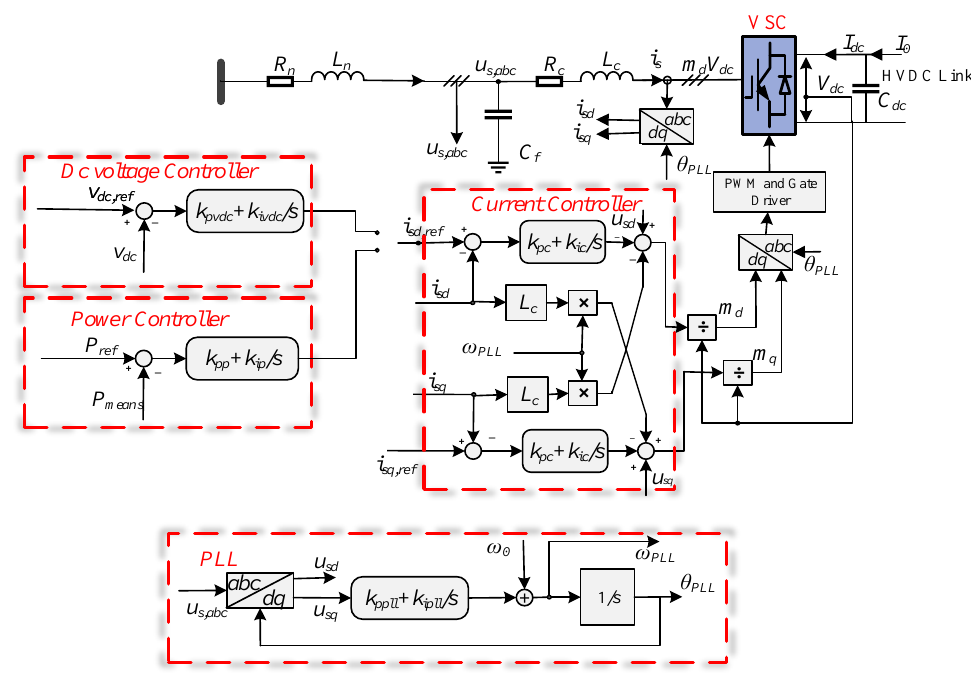
Figure 3. Control structure of the converters. Table 1. Simulation parameters.